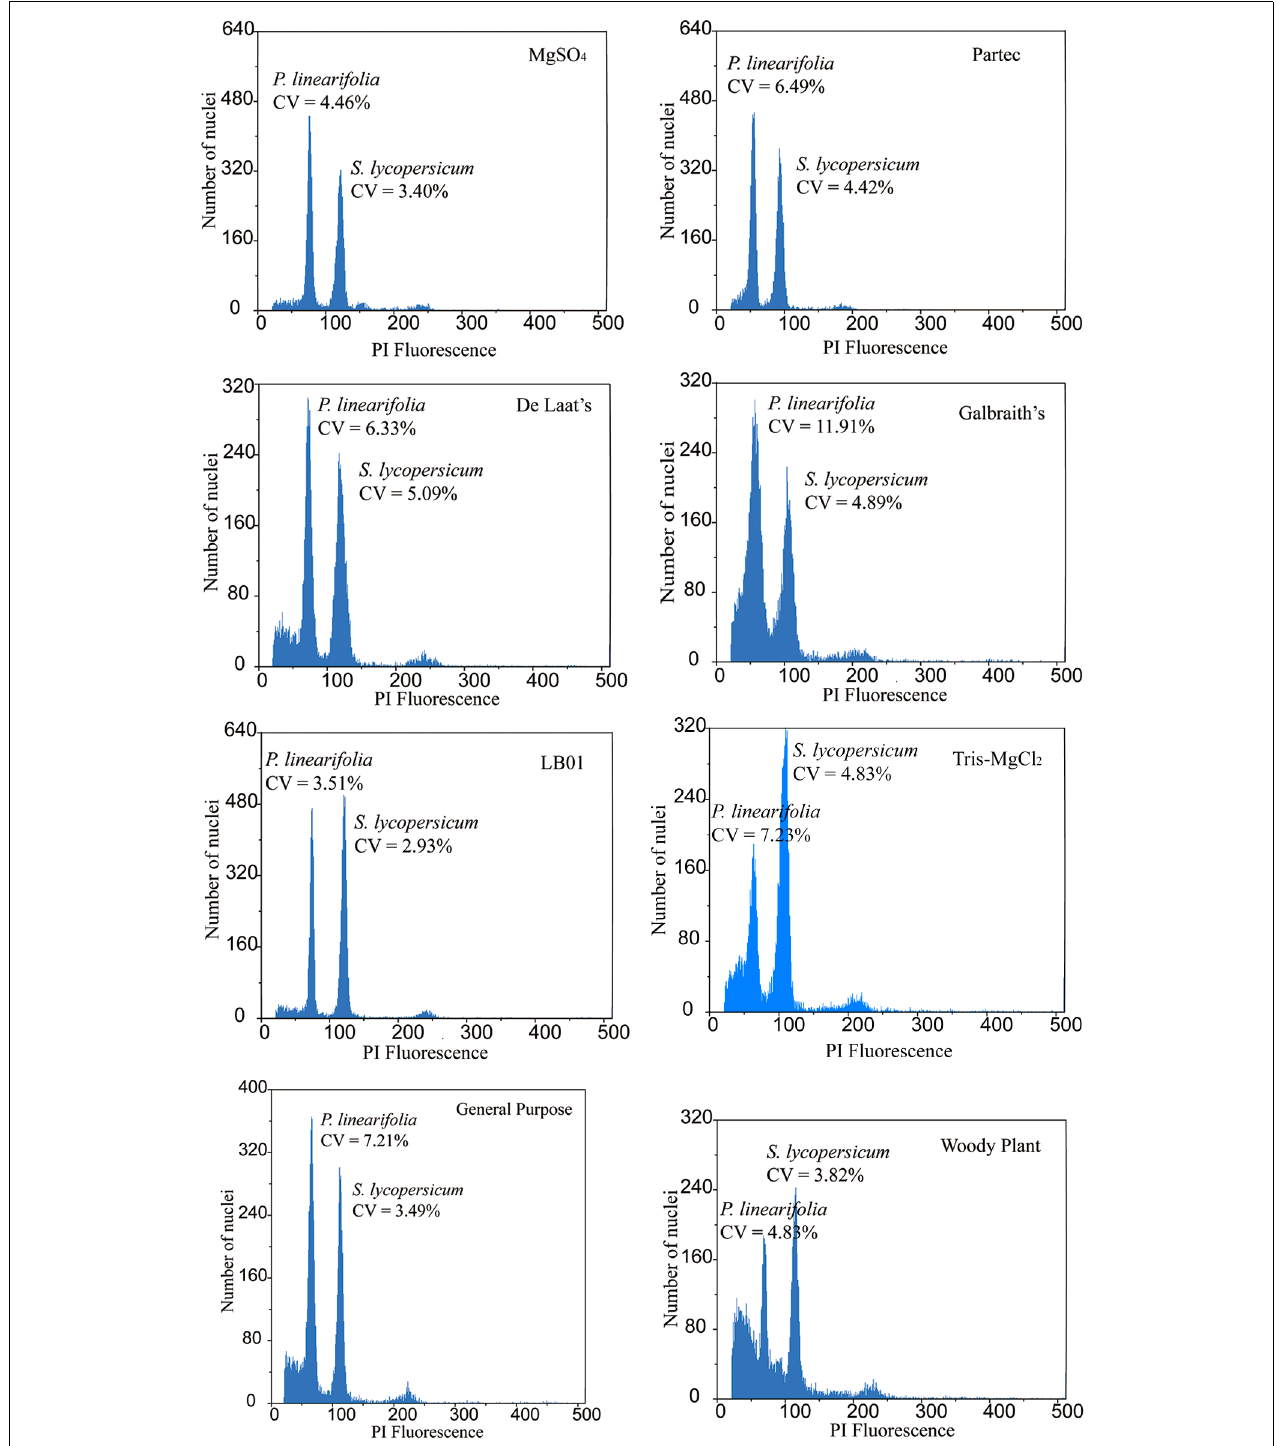
FIGURE 3 | Ungated histograms showing the range of quality of Primulina linearifolia obtained with eight different buffers.